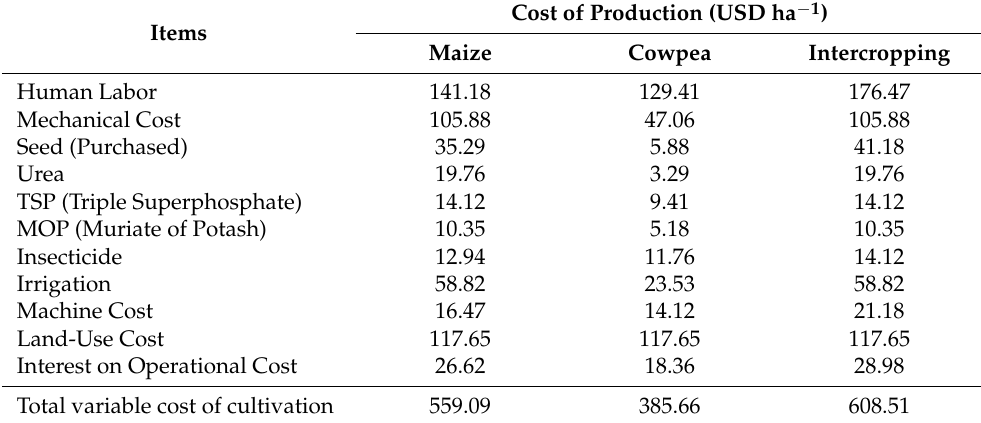
Table 1. Cost of production for different operations and product prices. The price was taken from the local market at Patuakhali on 15 November